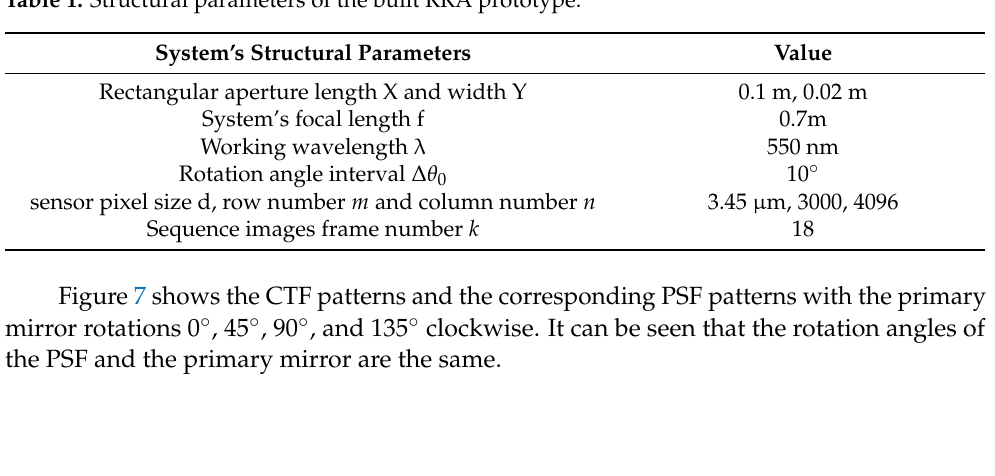
Table 1. Structural parameters of the built RRA